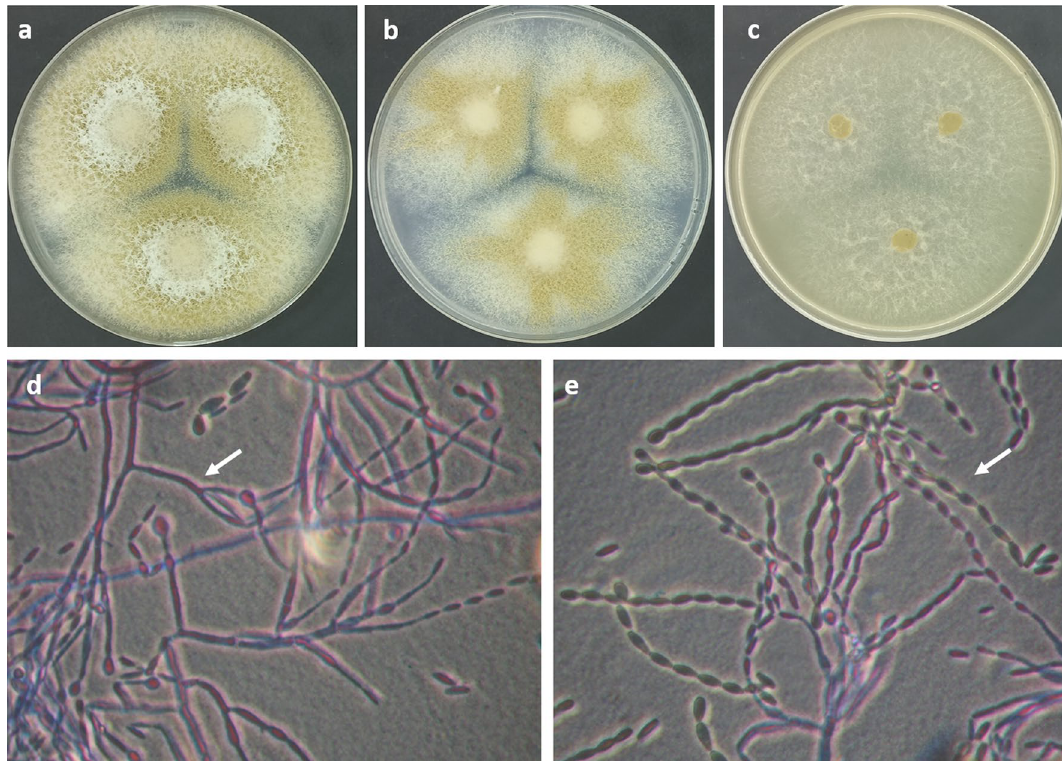
Figure 1. Paecilomyces sp. AUMC 15510: ( a – c ) 7-day-old colonies on PDA, Cz, and MEA at 25 °C. ( d ) Irregularly branched conidiophores with phialides. ( e ) Chains of ellipsoidal and/or cylindrical, truncate conidia. (White arrows).